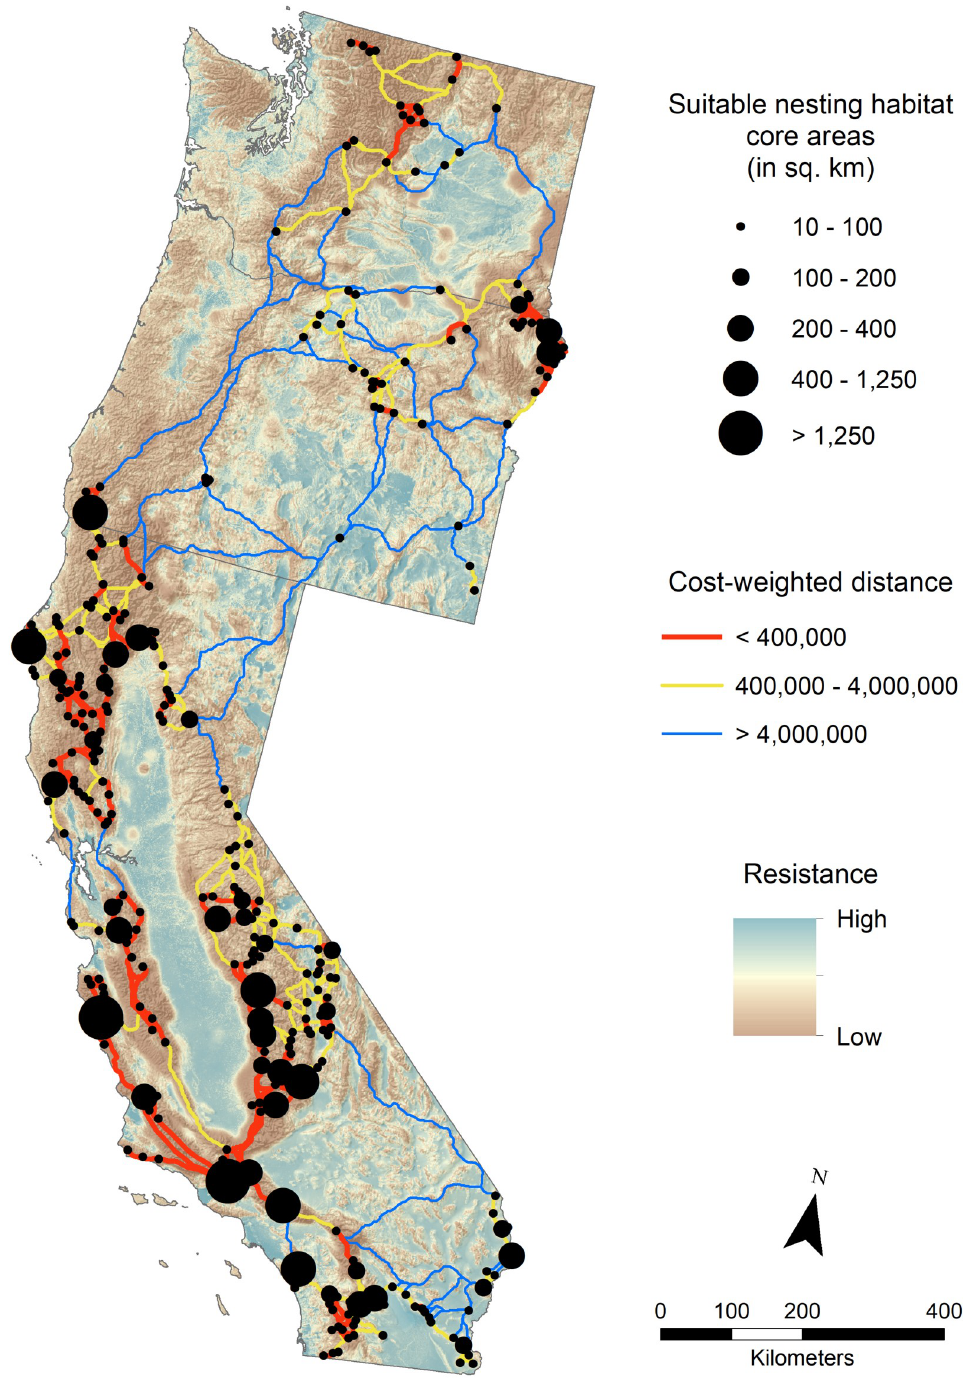
Fig 6. Least-cost-path linkages between California condor modeled core nesting habitats ( � 10 km 2 ) in Washington, Oregon, and California, USA. For display purposes, core nesting habitats are represented as points and linkages between large core nesting habitats were snapped to points through core nesting habitats while maintaining their least- cost path distances.